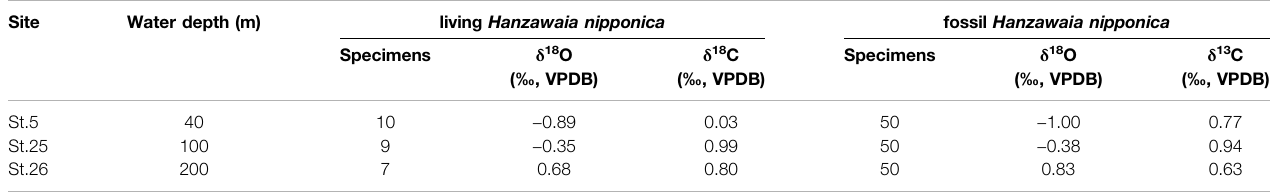
TABLE 4 | Oxygen and carbon isotopic compositions of living (stained) and fossil (non-stained) H. nipponica from three sites in Tosa Bay. Site Water depth